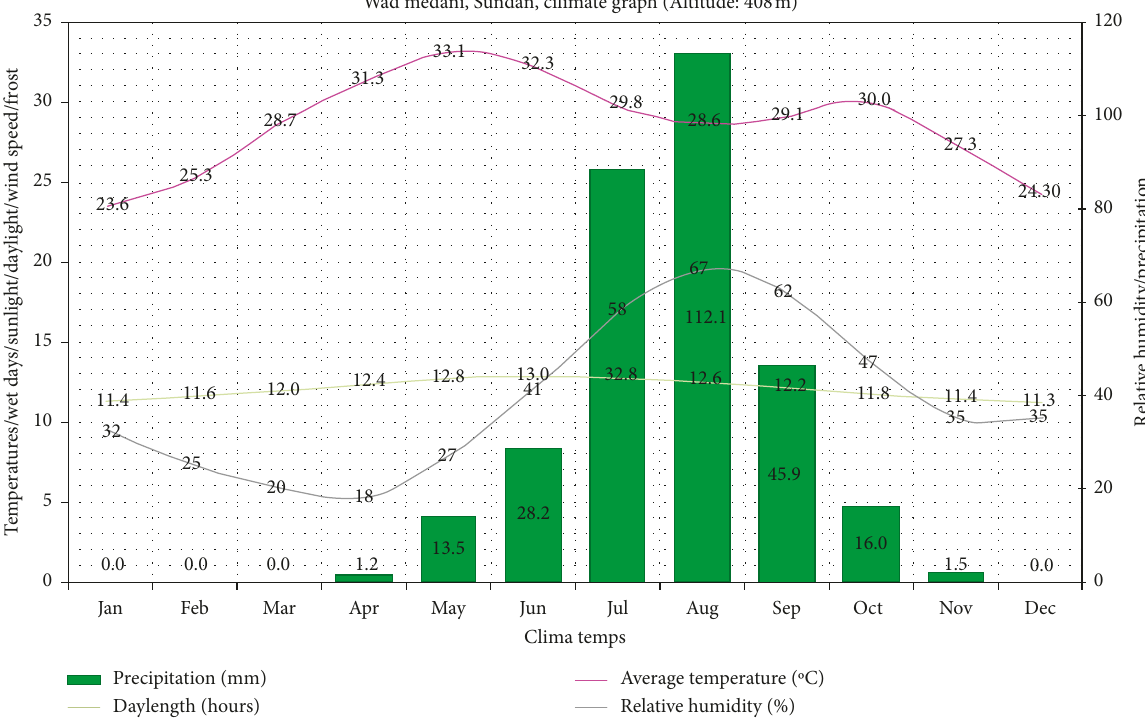
Figure 3: Wad Medani, Sudan, is at 14 °